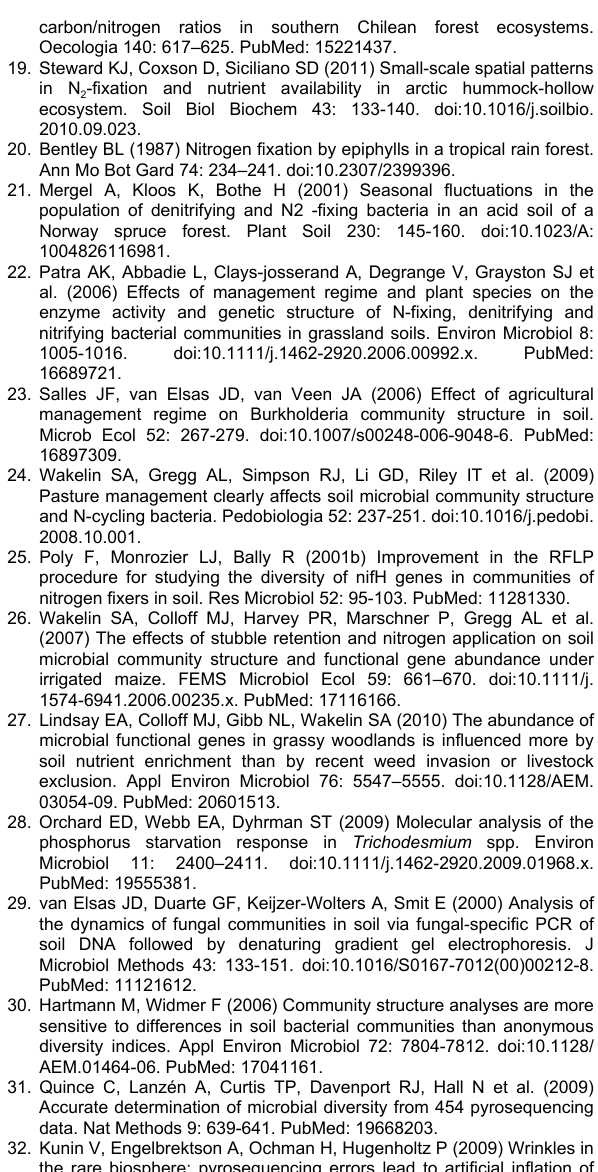
Table S5. Richness estimates and diversity indices for forward and reverse amplicon libraries at 90% similarity cutoff.